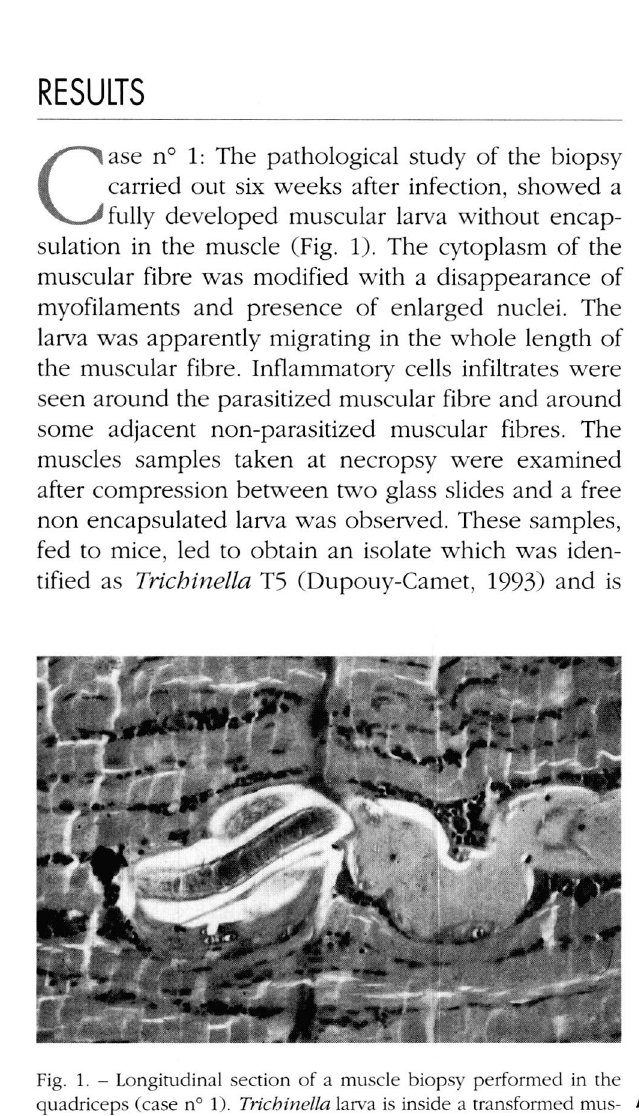
Fig. 1. - Longitudinal section of a muscle biopsy performed in the quadriceps (case n° 1). Trichinella larva is inside a transformed mus cular cell surrounded with a polymorphic cell infiltrate. The larva is non encapsulated six weeks afer infection. Original magnification x 400.